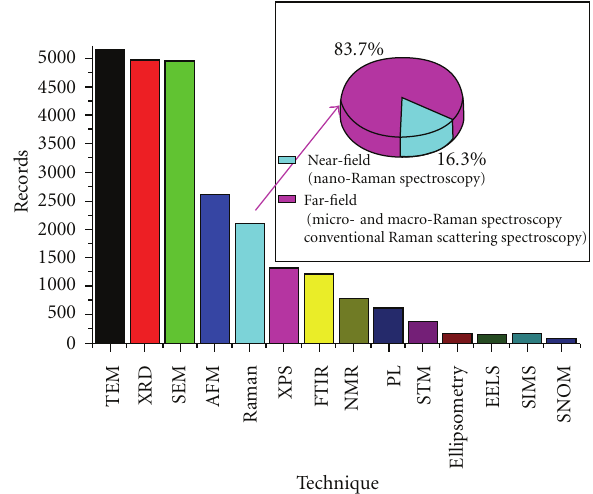
Figure 1: Number of records of the listed nanocharacterization tools used in probing nanostructures in the period of January 1996 to July 2010 (Source: ISI Web of Science, http://apps.isiknowledge .com/)